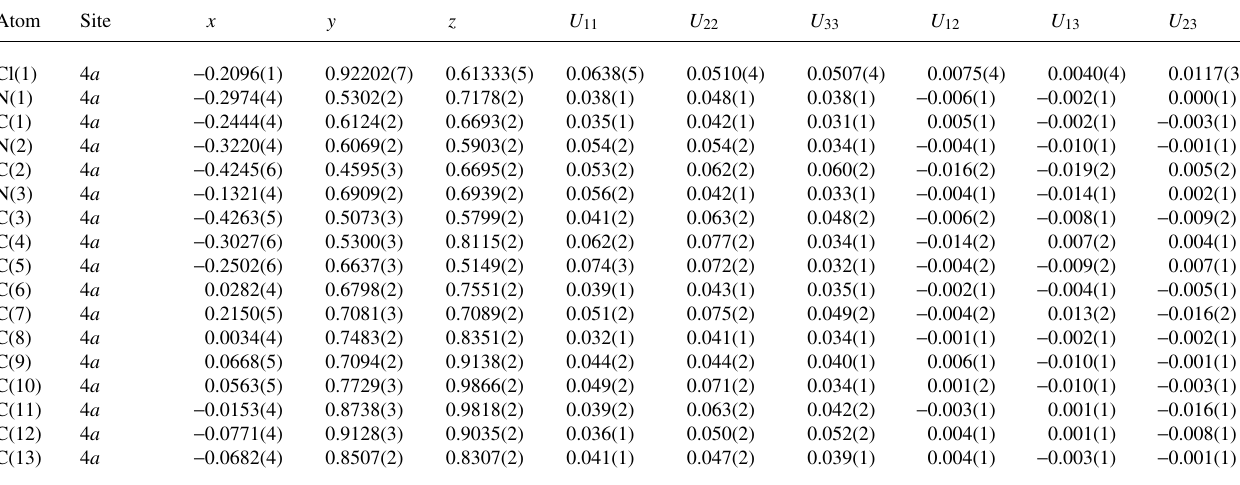
Table 3. Atomic coordinates and displacement parameters (in Å 2 )